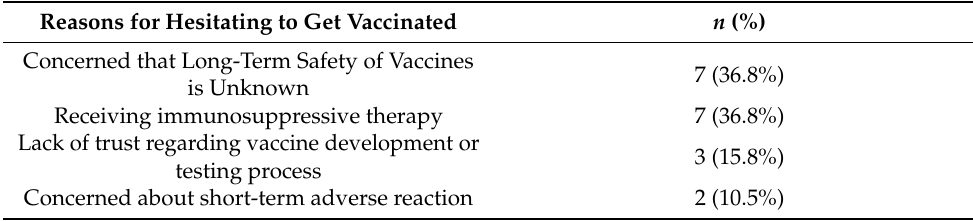
Table 3. Reasons for COVID-19 vaccination hesitancy.